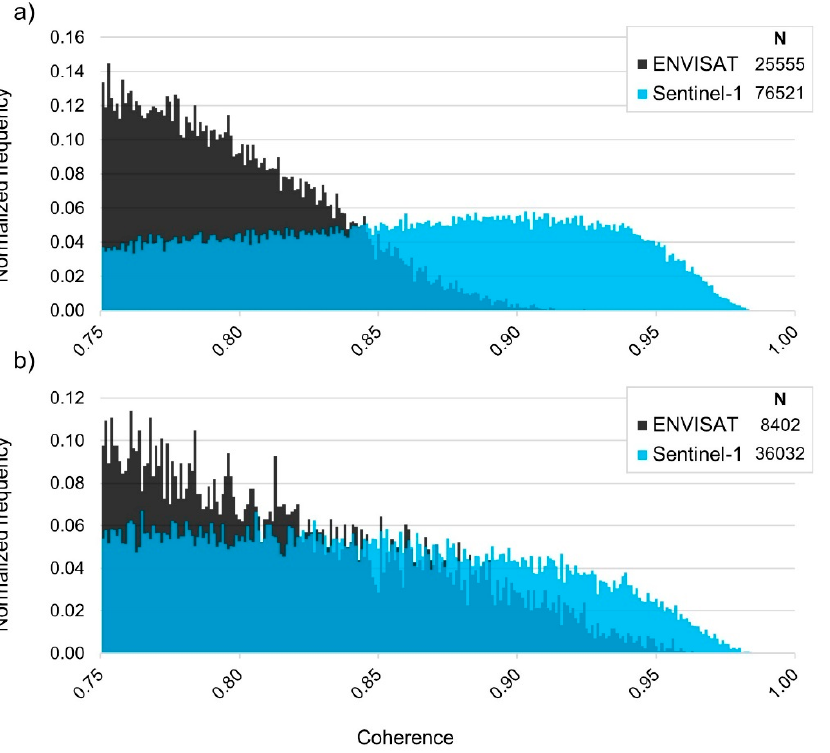
Figure 20. Frequency distribution of PS coherence extracted from ( a ) the Burren (AOI-1) and ( b ) the Navan town (AOI-2) for both satellites. N is the number of PSs. The distributions are normalized to the total number of PSs retrieved for each satellite.